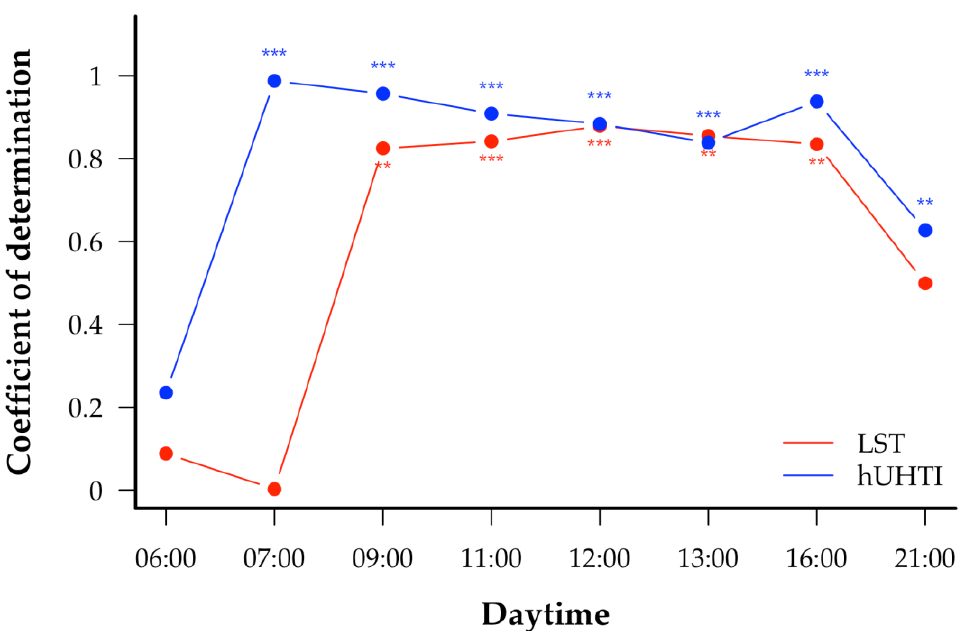
Figure 8. Coefficients of determination (R 2 ) related to simple linear regressions between ECOSTRESS Land Surface Temperatures (LST) and Envi-met modeled PET (red line) and related to simple linear regressions between hUHTI index and Envi-met modeled PET (blue line) at different daytimes (** = p value ≤ 0.01; *** = p value ≤ 0.001).